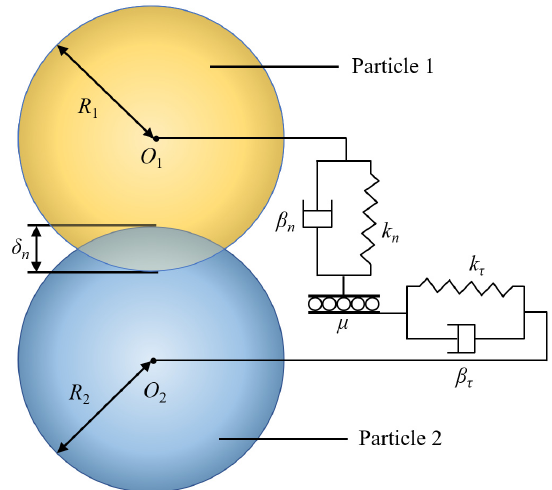
Figure 8. Hertz–Mindlin (no-slip) contact model. where O 1 and O 2 are the positions of the sphere centers of two particles, respectively; R 1 and R 2 are the radii of two particles, respectively, mm; δ n is normal overlap after collisions, mm; k n and k τ are the normal and tangential Hooke coefficients of particles, respectively; β n and β τ are the normal and tangential damping coefficients of particles, respectively; μ is the sliding coefficient between particles.